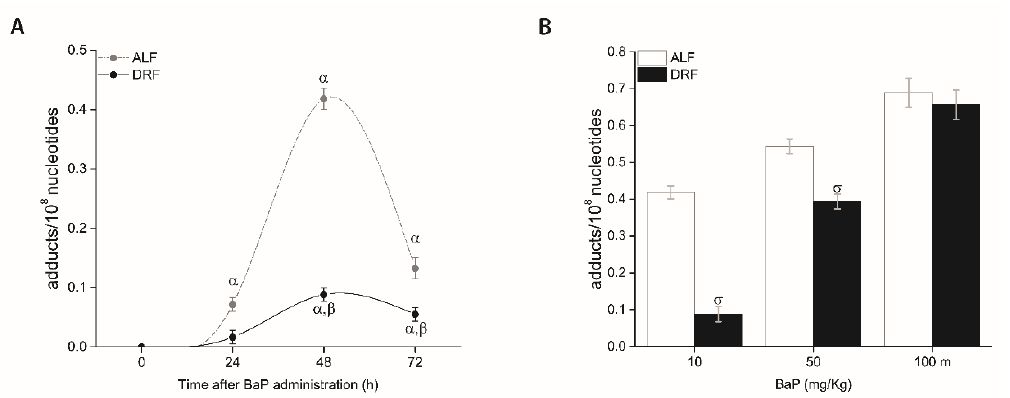
Figure 3. BPDE-DNA adduct levels in the liver of rats with ALF (gray circles) and DRF (black circles) after BaP administration at 10 mg/kg ( A ). BPDE-DNA adduct levels in the liver of rats with ALF (white bar) and DRF (black bar) after BaP administration at 10, 50, or 100 mg/kg ( B ). Each point corresponds to the mean ± SEM, n = 6. α p ≤ 0.05 compared to the control group that was fed with the same diet (DRF at ZT1 and ALF at ZT13), β p ≤ 0.05 compared to the ALF group at the same time point, and δ p ≤ 0.05 compared to the ALF group treated with the same concentrations of BaP.